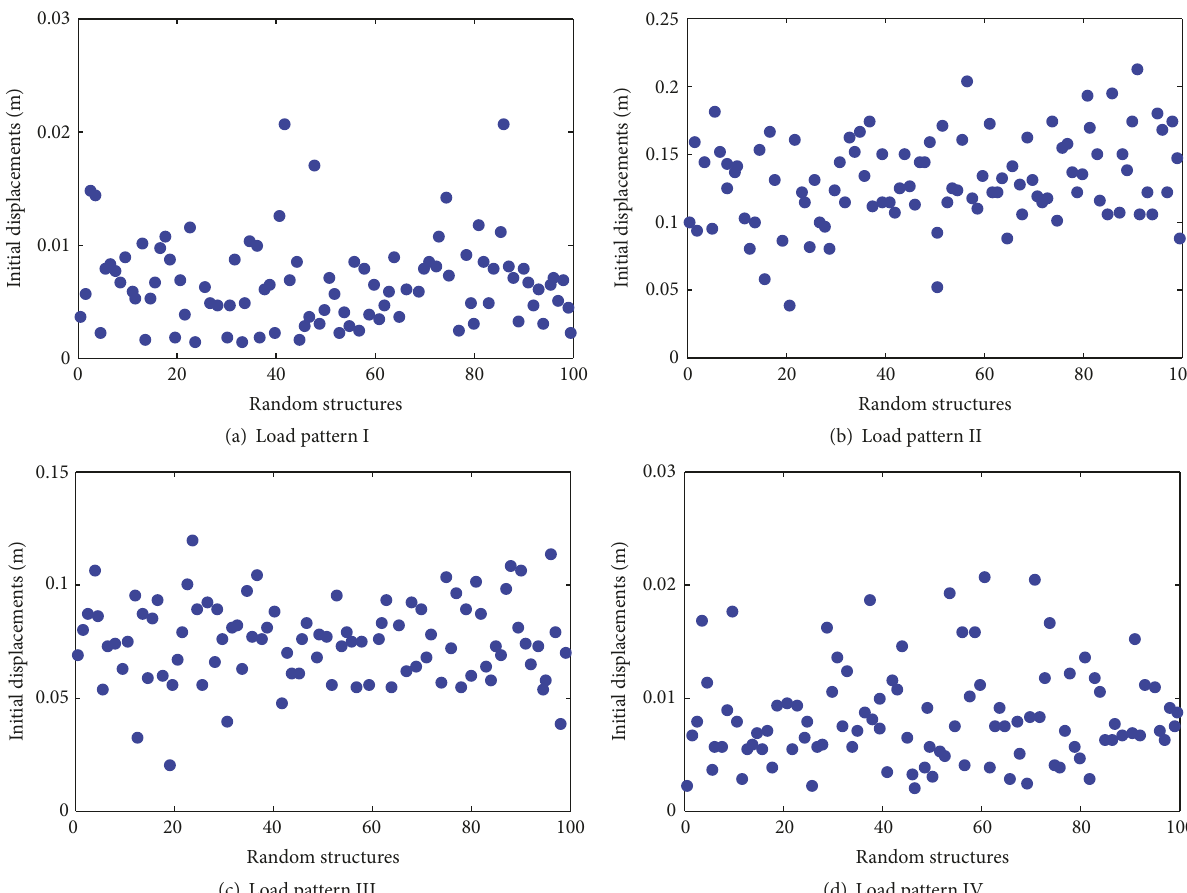
Figure 7: Random initial displacement of joint